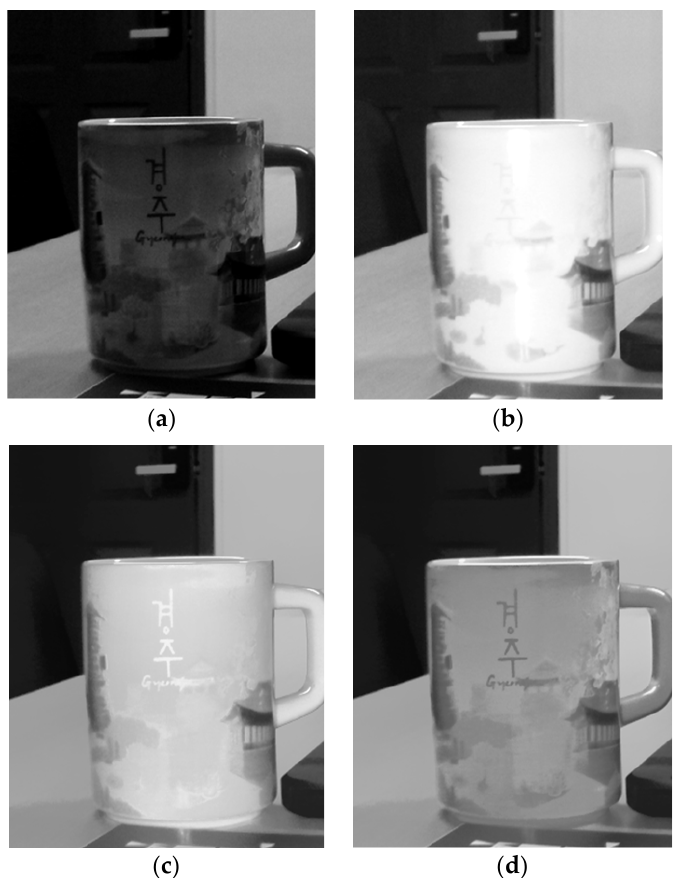
Figure 6. Comparison of results based on the bilateral filter map and the luminance saturation region map: ( a ) visible-light image, ( b ) near-infrared intensity image, ( c ) base layer synthesis result with the bilateral filter map, ( d ) base layer synthesis result with the joint bilateral filter map.